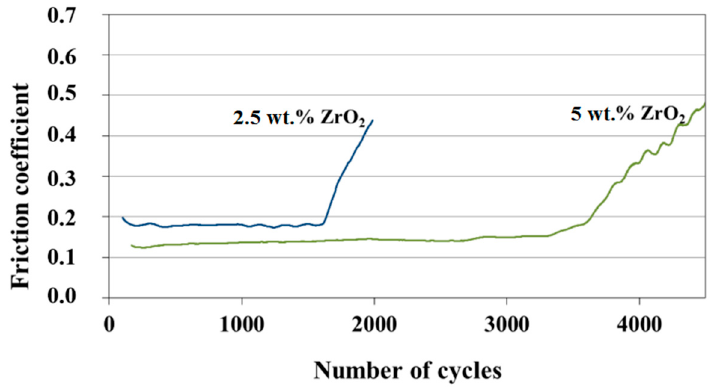
Figure 10. Friction coefficient for coatings with 2.5 wt.% and 5 wt.% of ZrO 2 with 10 N of load.